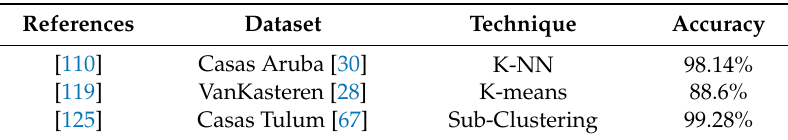
Table 11. Details of the best results of the